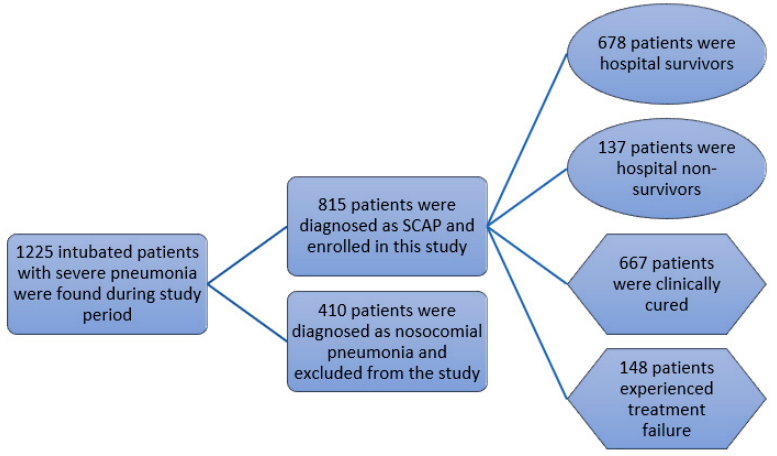
Figure 1. Flow diagram of population characteristics.